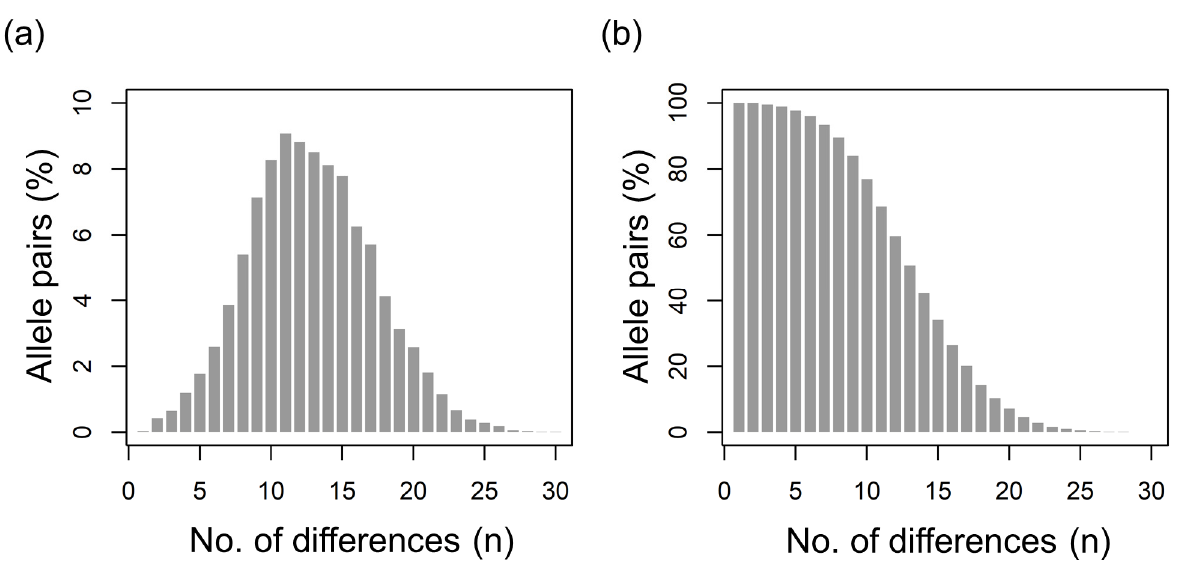
Figure 2. Study of the HVR csd variability via pairwise alignment of 160 non-identical alleles identified in the investigated honey samples. Differences considered the ∆ L HVR + N SAP values. ( a ) Distribution of the HVR differences (alignments presenting n differences). ( b ) Cumulative distribution of the HVR differences (% of alignments presenting ≥ n